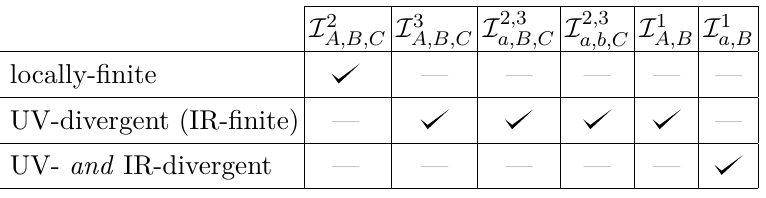
Table 2 . Properties of basis integrands defined in B (3)